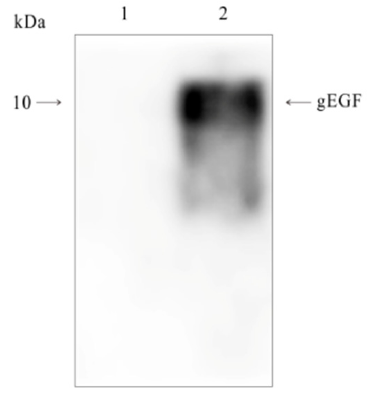
Figure 1. Hybridization of the His-tag monoclonal antibody with the gEGF protein produced by the Lactococcus lactis recombinant strain. Lanes 1 and 2: 20 μ L/well of the supernatants from the LL-pNZ8149 and the LL-pNZ8149-gEGF fermentation products, respectively. The recombinant gEGF is marked by an arrowhead.